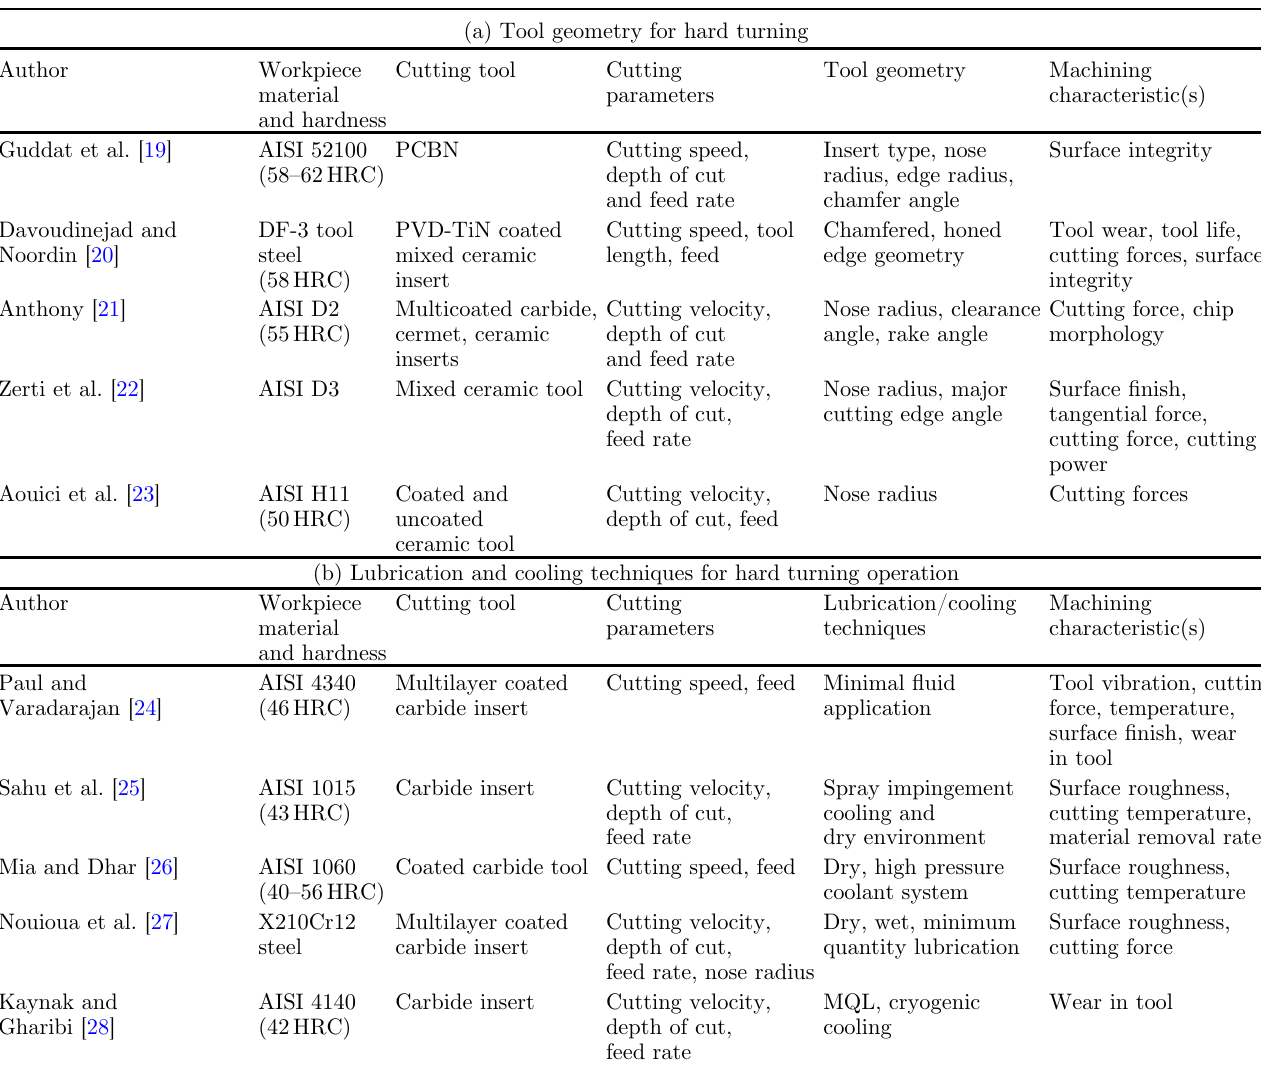
Table 1. Overview of various work and cutting tool materials along with machining process variables for hard turning. (a) Tool geometry for hard